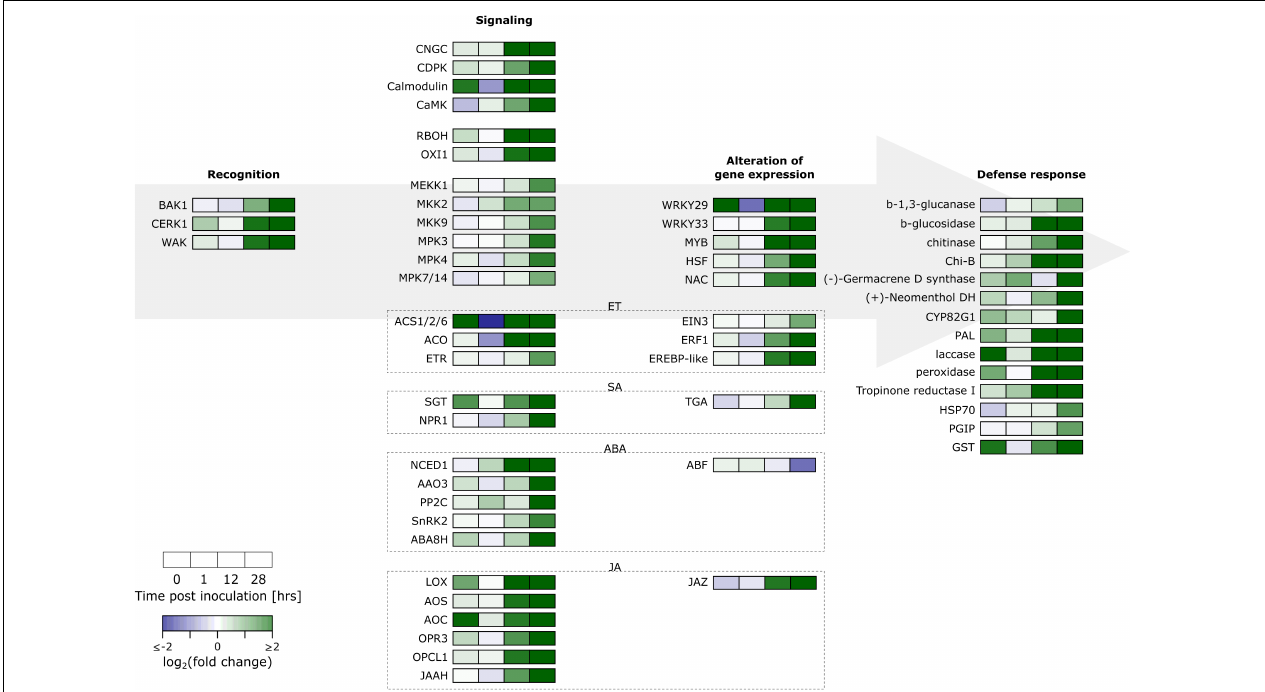
FIGURE 2 | Overview of gene expression responses of “Jonagored” apple to B. cinerea inoculation. BAK1, Brassinosteroid insensitive-associated receptor kinase 1; CERK1, Chitin elicitor receptor kinase 1; WAK, Wall-associated kinase-like; CNGC, Cyclic nucleotide gated channel; CDPK, Calcium-dependent protein kinase; CAMK, Ca 2 + /calmodulin-dependent protein kinase; RBOH, Respiratory burst oxidase homolog; OXI1, Oxidative signal-inducible1 serine/threonine-protein kinase; MEKK, Mitogen-activated protein kinase kinase kinase; MKK, Mitogen-activated protein kinase kinase; MPK, Mitogen-activated protein kinase; ACS1/2/6, 1-Aminocyclopropane-1-carboxylate synthase 1/2/6; ACO, 1-Aminocyclopropane-1-carboxylate oxidase; ET, Ethylene; ETR, ET receptor; EIN3, ET-insensitive protein 3; ERF1, ET-responsive transcription factor 1; EREBP, ET-responsive element binding protein; SA, Salicylic acid; SGT SA glucosyltransferase;